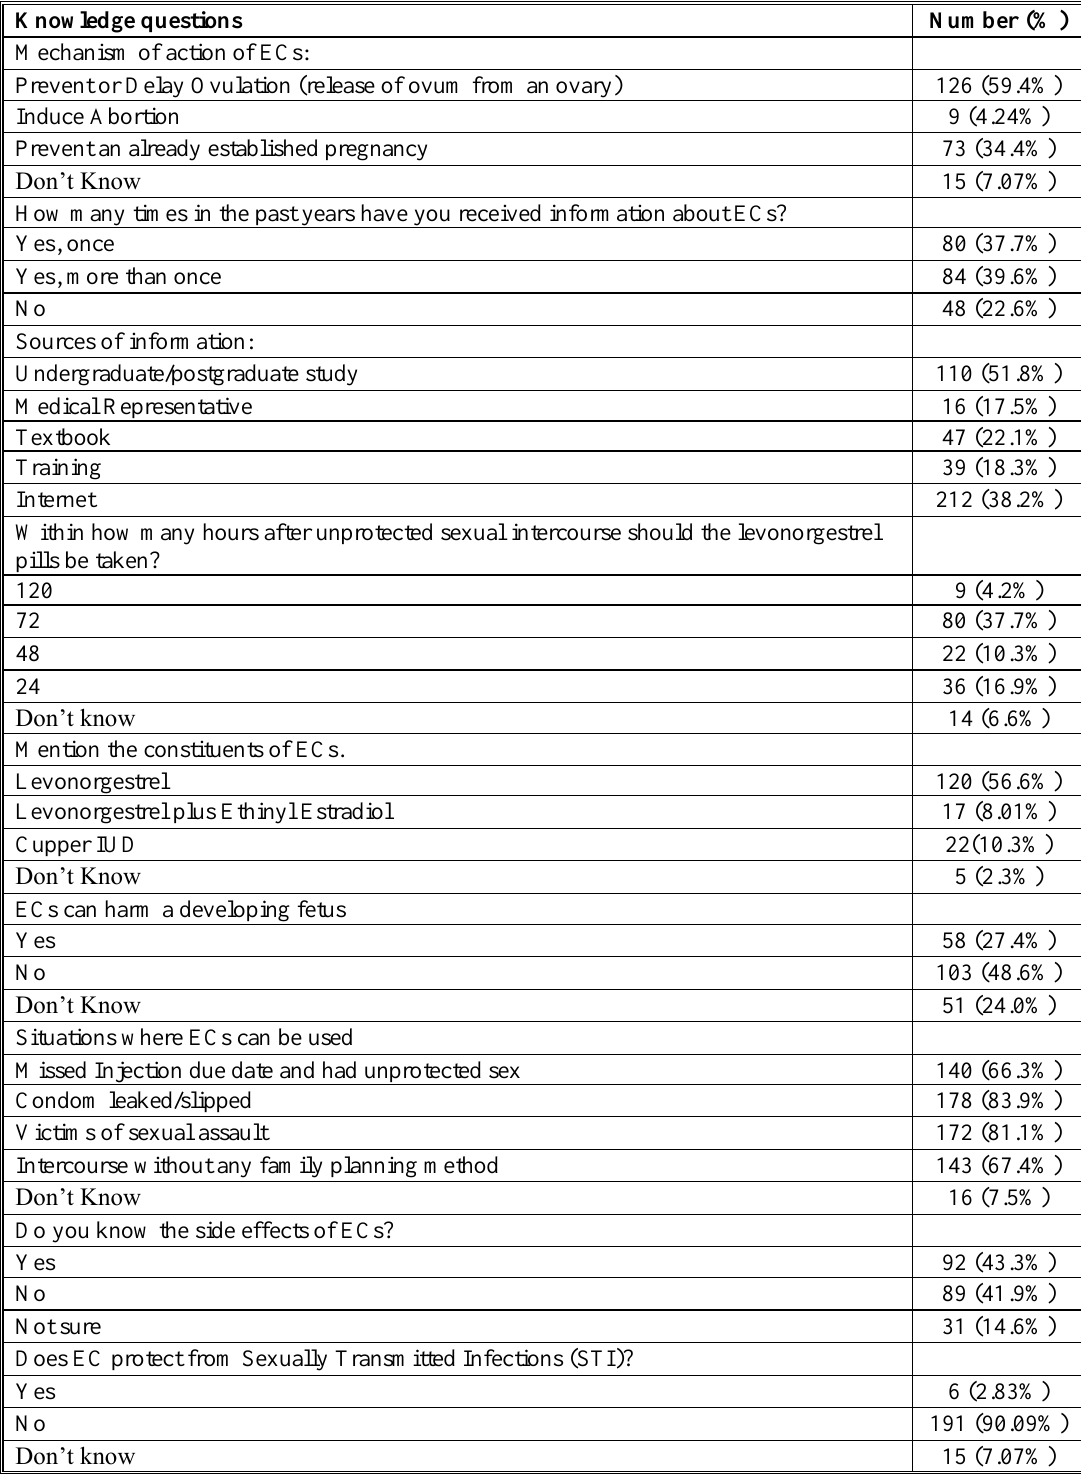
Table 2. Knowledge of community pharmacists towards emergency